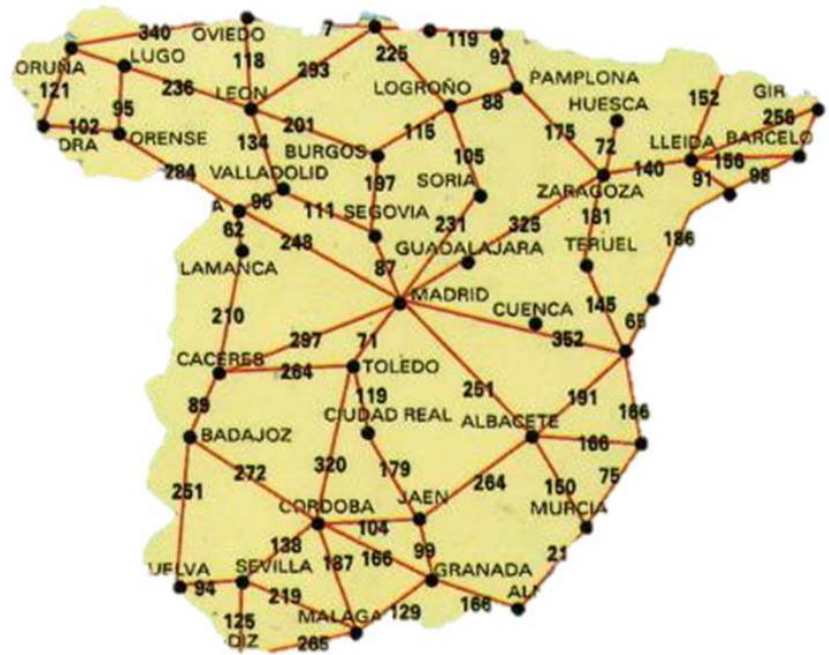
Figure 8. Major cities fast charging network and distances.